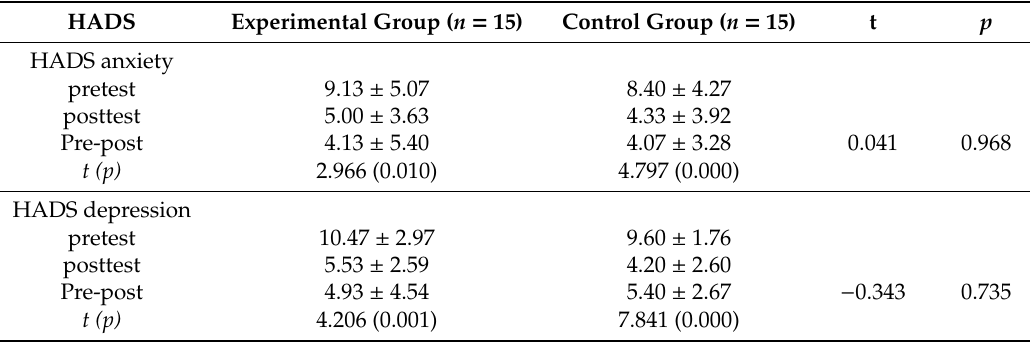
Table 6. The changes in the hospital anxiety and depression scale (HADS) ( n =